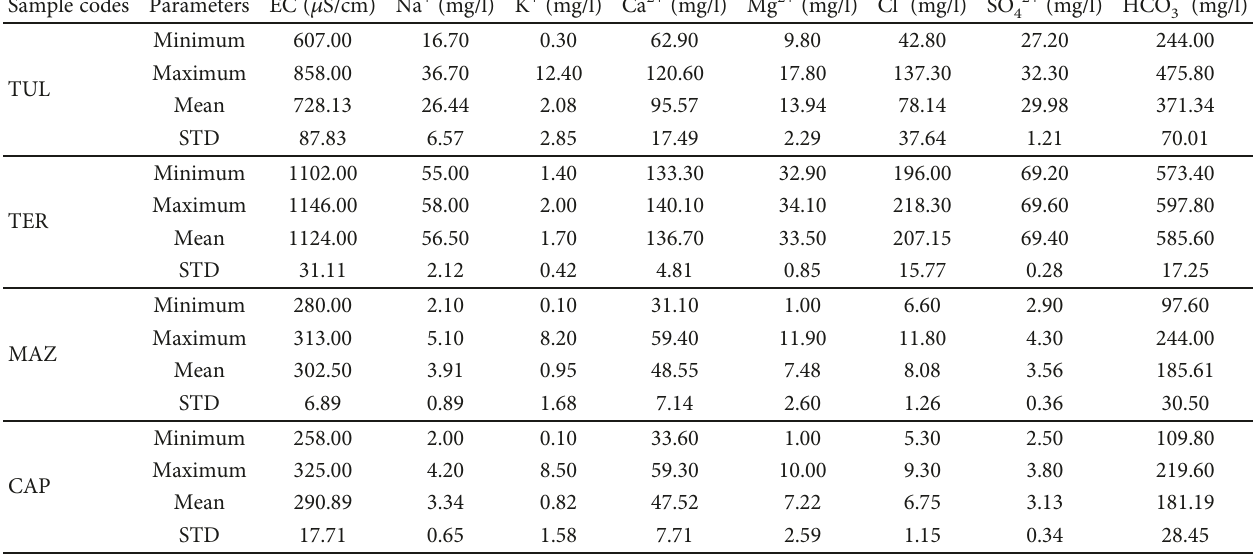
Table 2: Descriptive statics of analysed parameters in the groundwater samples.